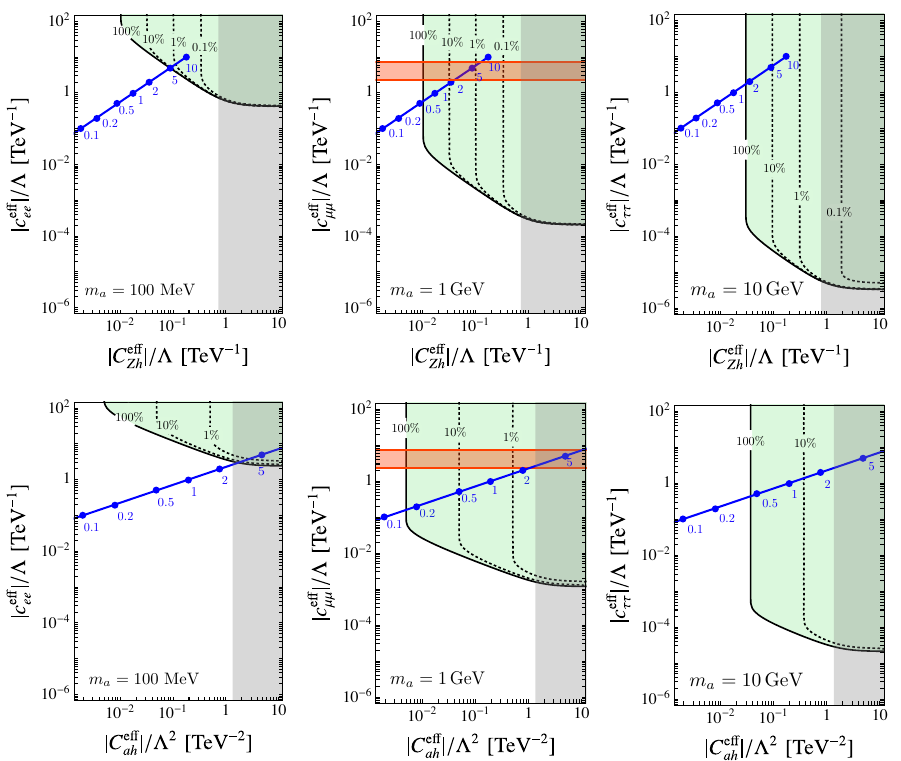
Figure 20 . Parameter space in the plane of the ALP-lepton and ALP-Higgs couplings (green regions to the right of the black contours) for which at least 100 events are produced in the h Za ‘ + ‘ (cid:0) ‘ + ‘ (cid:0) (top) and h aa ‘ + ‘ (cid:0) ‘ + ‘ (cid:0) (bottom) search channels at the LHC Run-2 with 1 1 ! ! ! 300 fb (cid:0) 1 and for m a = 10 GeV, 1 GeV and 100 MeV. The contours correspond to Br( a (solid) and 0.1, 0.01, 0.001 (dotted), as indicated. The gray area indicates the region excluded